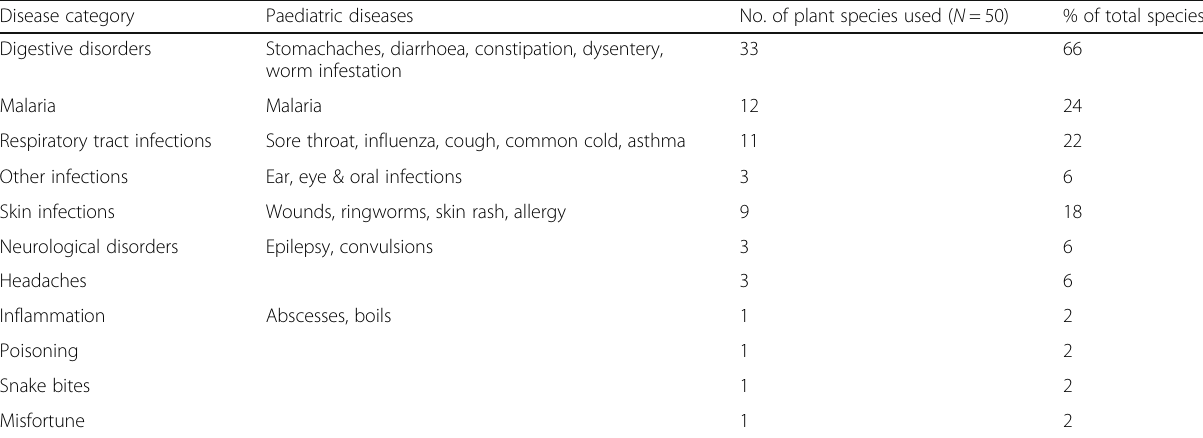
Table 3 Disease categories treated by different medicinal plant species Disease category Paediatric diseases